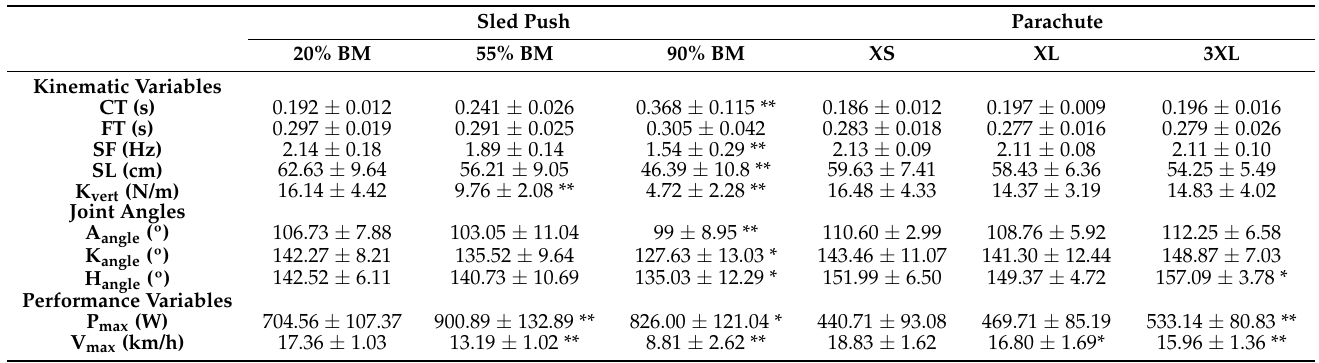
Table 1. Kinematics and performance variables of sled push and resisted-parachute sprinting with different load conditions, data is presented as mean ±